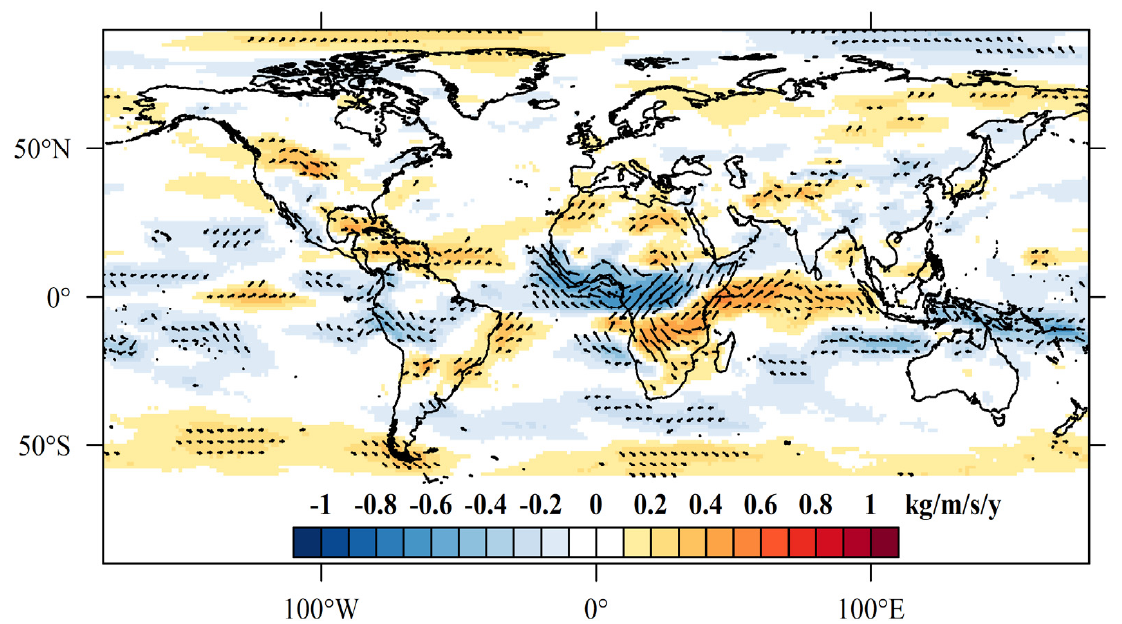
Figure 4. Spatial patterns of annual trends of the water vapor flux during 1975–2017 based on the Mann - Kendall test. The red (blue) shades represent the degree of positive (negative) trends at the 0.05 level. The arrow represents the direction of the water vapor flux and its length represents the magnitude of significance. Blank areas indicate that the trend is not significant.